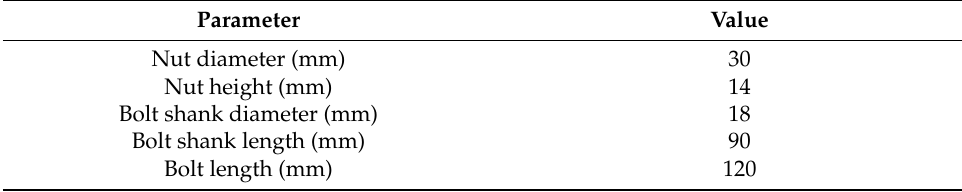
Table 2. Main parameters of bolts.